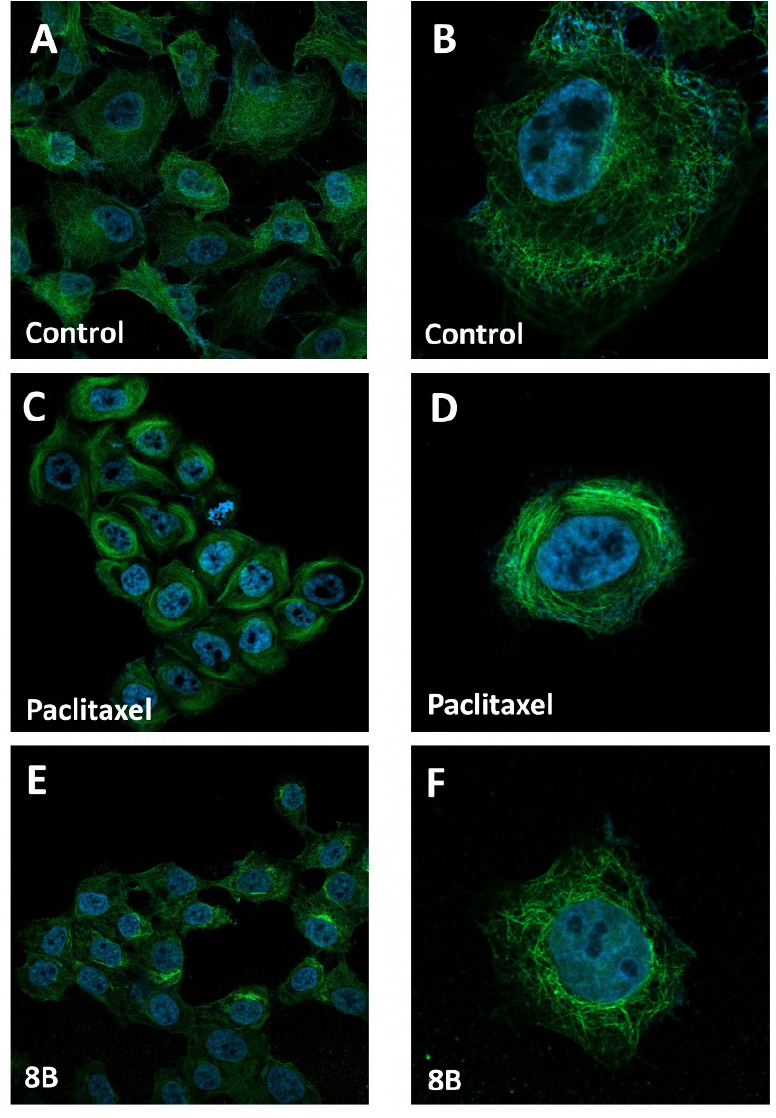
Figure 3. Effect of paclitaxel and 8B on microtubules in MSTO-211H cells. Microtubules in cells were visualized by confocal microscopy after treatment for 4h with vehicle (control, A , B ), 1 µ M paclitaxel ( C , D ) and 100 µ M 8B ( E , F ). Cells were stained with the antibody conjugate Alexa Fluor 488 mouse anti- β -tubulin (green) and DAPI (blue) to detect microtubules and nucleus, respectively. Starting from these considerations and based on the interesting cytotoxic effect of 8B , we investigated the cell death mediated by the NP, in comparison with paclitaxel, to assess the mechanism of cell death. In detail, the most sensitive MSTO-211H were incubated with 8B or paclitaxel for 24 h at a concentration about three times higher with respect to the GI 50 value, stained with Annexin V-FITC/propidium iodide and analyzed by flow cytometry. Annexin V stains apoptotic cells by binding to phosphatidylserine, a marker of apoptosis, while propidium iodide stains late apoptotic and necrotic cells because it is internalized only in cells undergoing the loss of plasma and nuclear membrane integrity. Figure 4 shows the dot plots of a representative experiment (A) and the percentages of viable, apoptotic, and necrotic cells